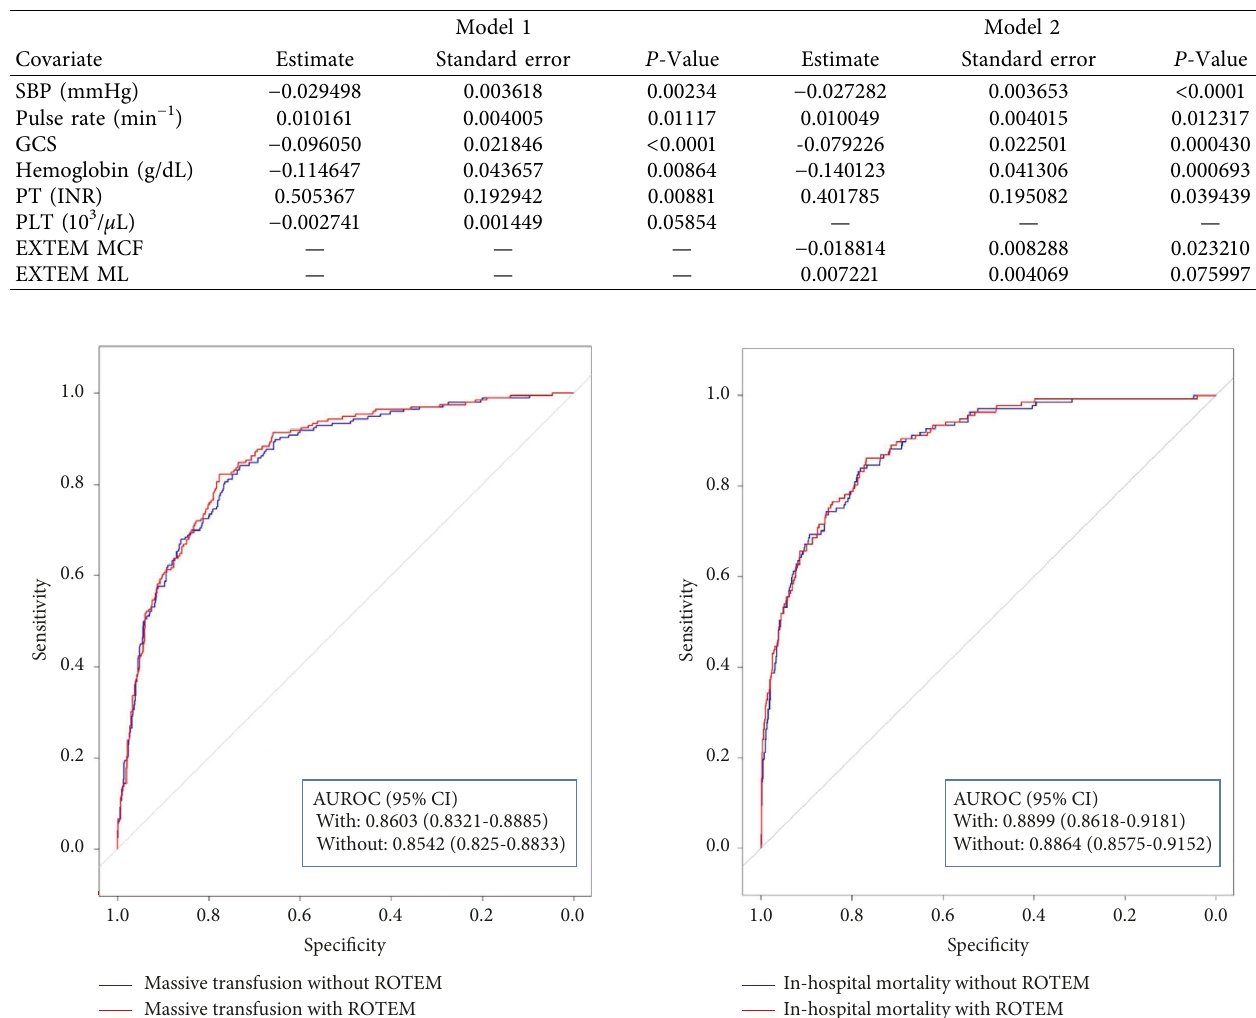
Table 3: Parameter estimates of Logistic Regression for Model 1 containing only Clinical Data, and Model 2 containing Clinical and ROTEM Data, as predictors of Massive Transfusion. SBP :Systolic blood pressure; GCS :Glasgow coma scale; PT (INR): prothrombin time (international normalized ratio); MCF: maximum clot firmness; ML: maximum lysis.